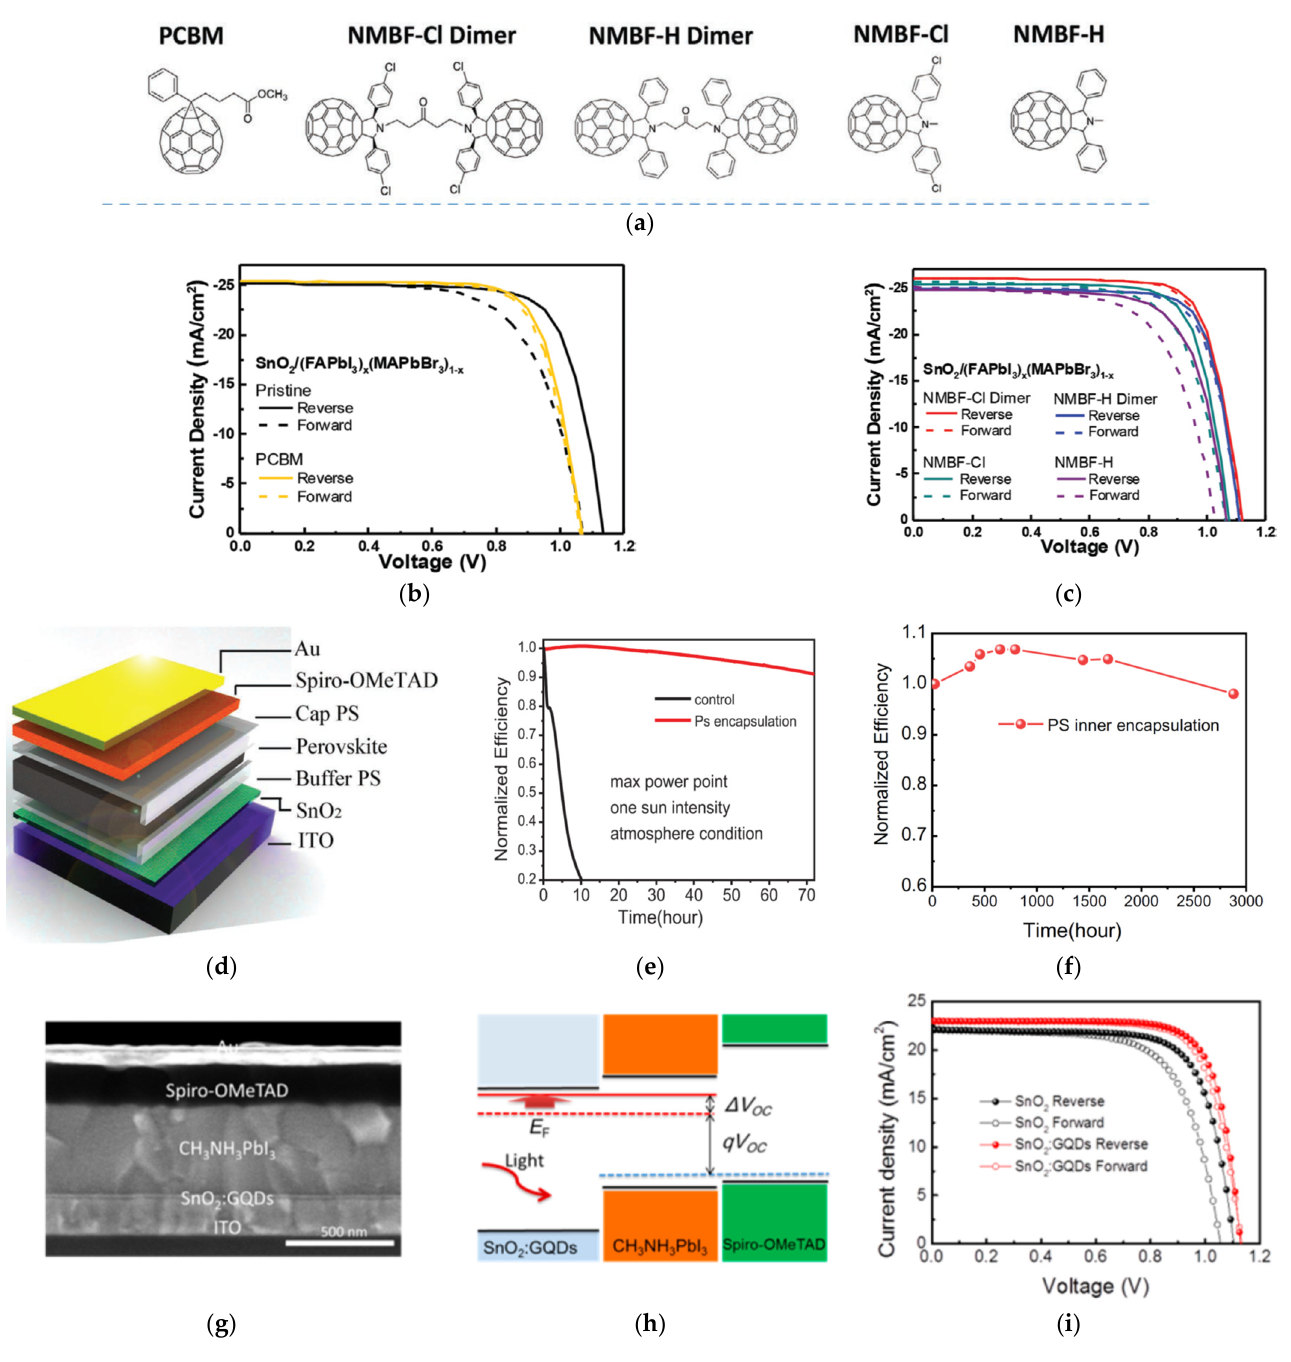
Figure 5 . ( a ) Chemical structures of fullerene dimers and monomers. Illuminated J-V curves under 1 SUN for reverse- and forward-voltage scans of ( b ) SnO 2 and SnO 2 /PCBM-based, and ( c ) SnO 2 /NMBF-Cl and SnO 2 /NMBF-H monomer and dimer-based PSC devices. Reproduced from [56] with permission from Wiley, 2020. ( d ) Schematic of PSC-device stack based on polystyrene (PS) modified SnO 2 ETL. ( e ) Stability tests at the MPP under 1 SUN illumination. ( f ) Long-term stability measurements of devices with inner-PS encapsulation stored in air. Reproduced from [57] with permission from Wiley, 2019. ( g ) Cross-sectional scanning electron microscopy (SEM) image of device with SnO 2 /GQDs ETL. ( h ) Energy-band levels of device based on SnO 2 /GQDs before and after illumination. ( i ) Illuminated J-V curves under 1 SUN for various ETLs. Reproduced from [58] with permission from ACS Publishing, 2017 .